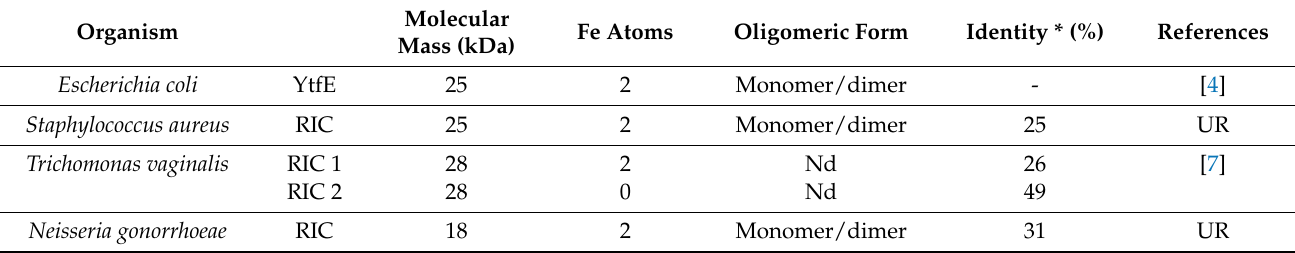
Table 1. Studied microbial RIC